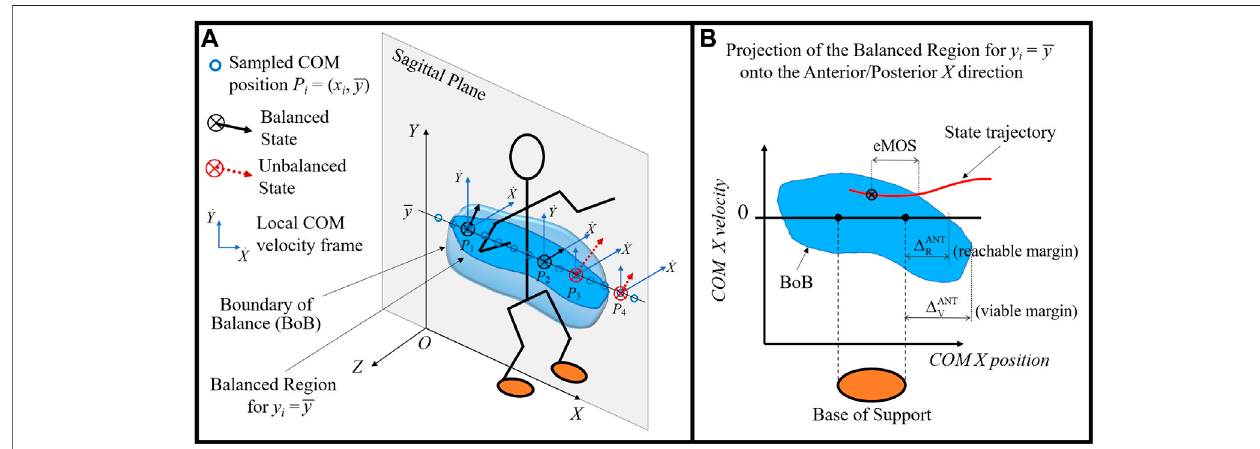
FIGURE 1 | (A) Illustration of the balanced region concept (blue volume) and its boundary (BoB) in the sagittal plane of a biped system. At each sampled COM position(circles),themaximumfeasiblerangeofCOMvelocitiyperturbationsarecalculatedandshownwithrespecttolocalvelocityframes.Examplesofbalancedstates at positions P 1 and P 2 and unbalanced states at positions P 3 and P 4 are shown, whose COM velocities fall inside and outside of the BoB, respectively. (B) The BoB is projected onto the ( X , _ X ) plane to illustrate the concepts of viable and reachable boundary margins and their relationship with the base of support. The instantaneous state margin (eMOS) is also